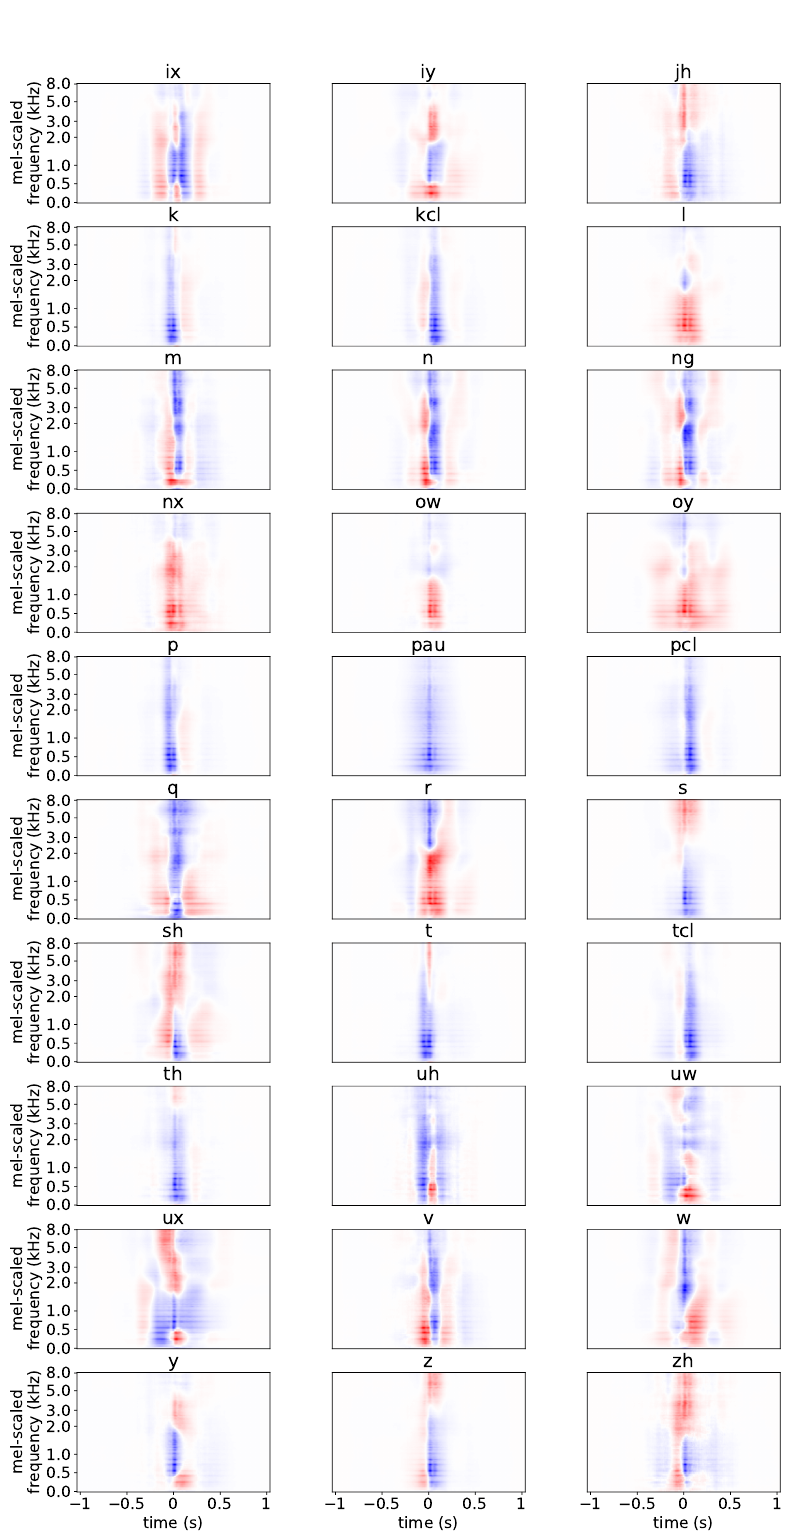
Figure A5. Input layer SNAPs in model W2L for phonemes ix – zh